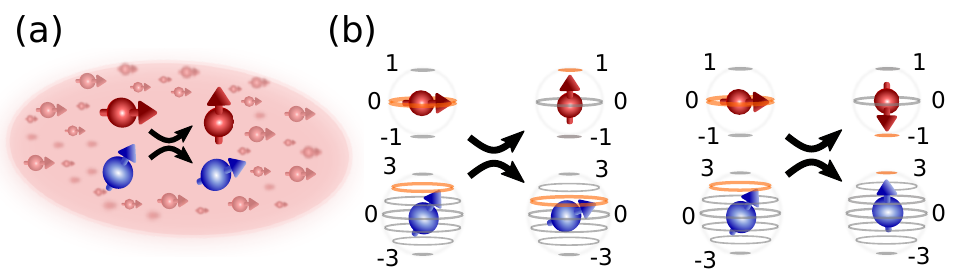
Figure 1: Single Cs atom immersion in an ultracold Rb bath and microscopic in- teraction mechanisms. (a) Impurity atom (blue) inside the ultracold Rb bath (red). Exemplarily one SE collision is shown. Internal Zeeman level structures with three (seven) states for Rb (Cs) are presented as Bloch spheres in (b). Current atom states are indicated by the spin tilt and highlighted in orange on the spheres to illustrate both spin-exchange processes exoergic in the left and endoergic in the right